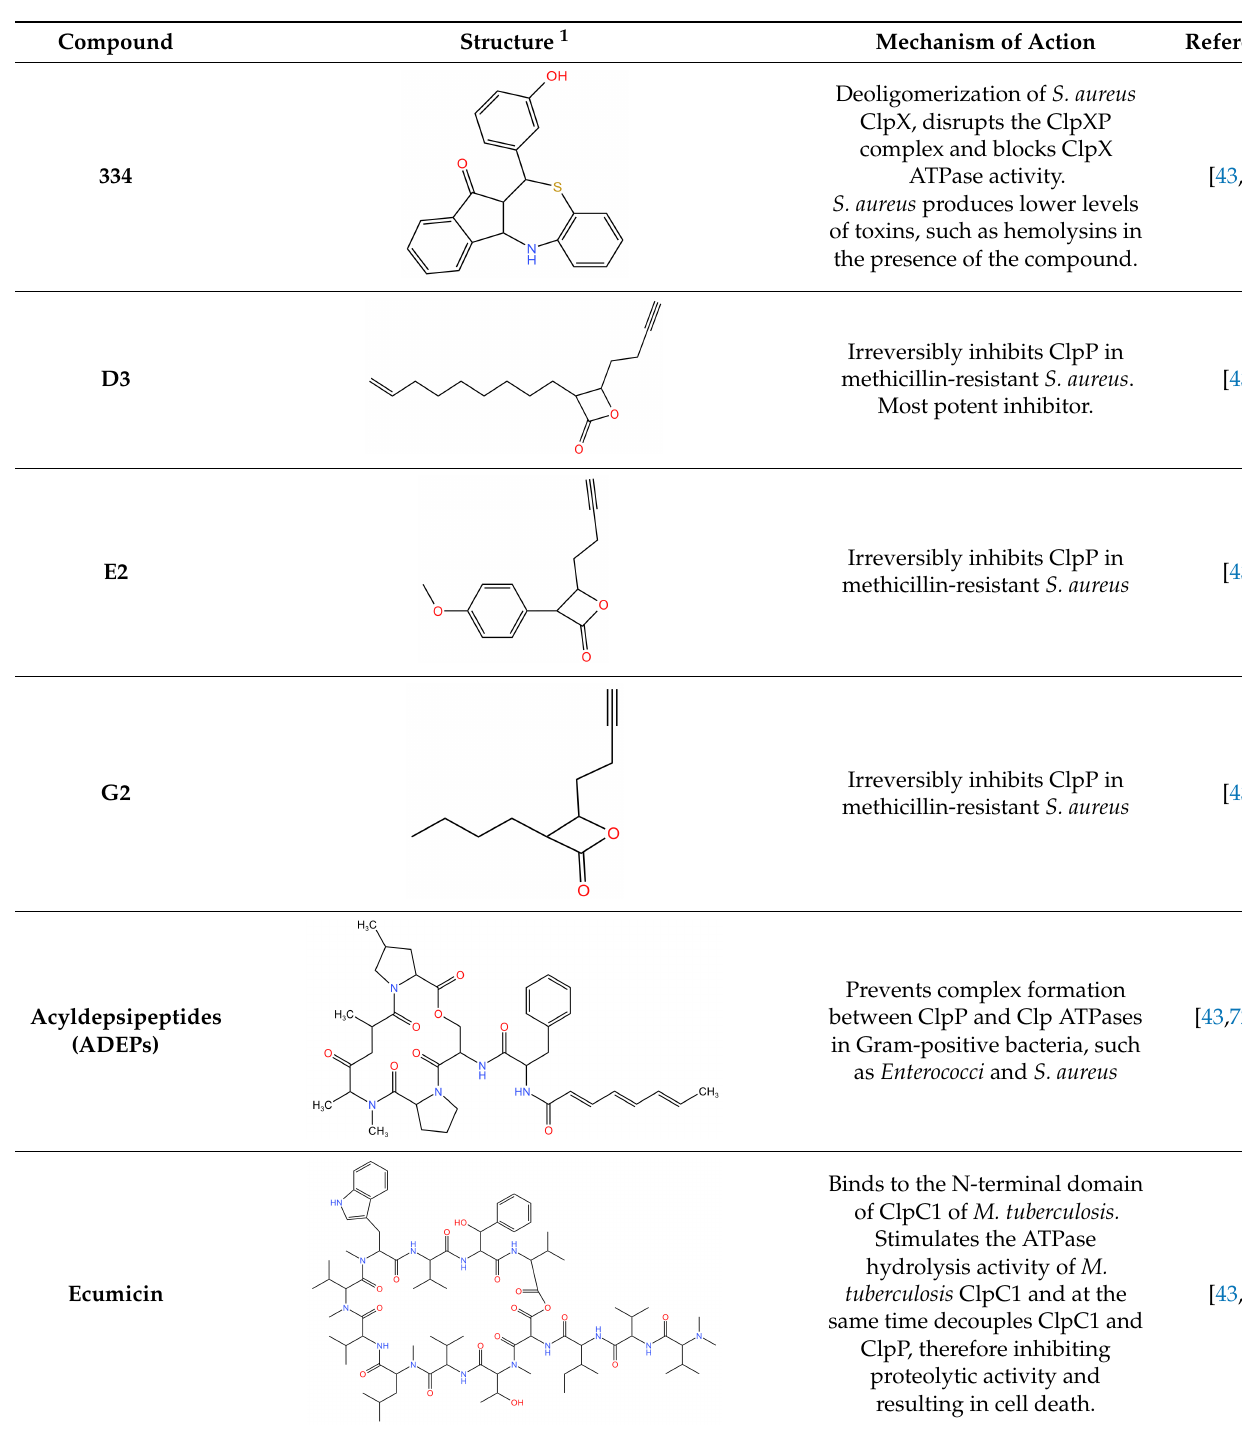
Table 4. Compounds developed as potential targets for Clp